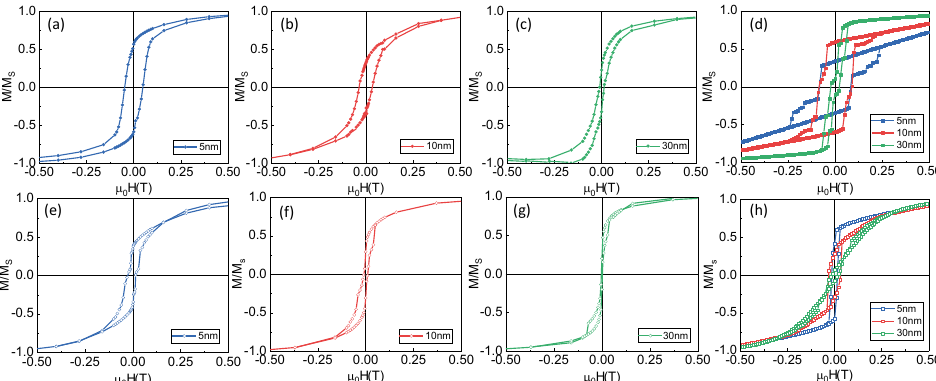
Figure 4. Influence of the thickness of the external magnetic layer in the hysteresis loops for FeNi/Au(5 nm)/Co NWs. Hysteresis loops measured with the field applied parallel (panels ( a – c )) and perpendicular to the longitudinal axis of the NWs (panels ( e – g )). Panels ( d ) and ( h ) correspond to micromagnetic simulations of the magnetic external